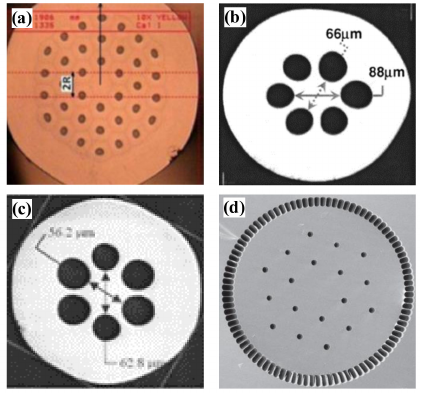
Figure 9. ( a ) All-solid large mode area (LMA) fiber [51] reported by IMRA, 2009. ( b ) LCF for passive leaky channel fiber designed by IMRA, 2007 [73]; ( c ) LCF for Yb-doped leaky channel fiber designed by IMRA, 2007 [73]; ( d ) large-pitch photonic crystal fiber